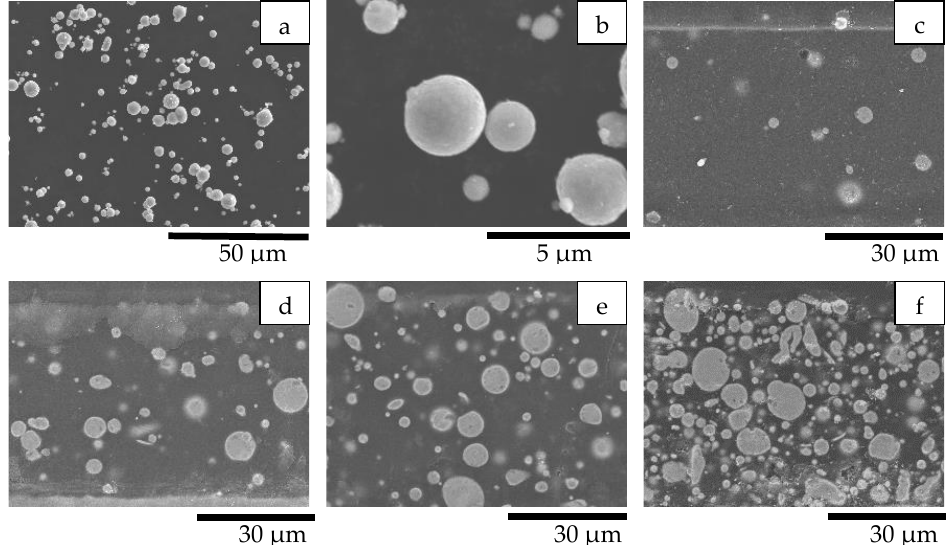
Figure 1. SEM images. ( a , b ) Zinc particles; ( c – f ) cross-sections of coatings with 20, 40, 60, and 80% zinc in PC. ( a ) Zn; ( b ) Zn; ( c ) Zn – 20%-PC; ( d ) Zn – 40%-PC; ( e ) Zn – 60%-PC; ( f ) Zn – 80%-PC.